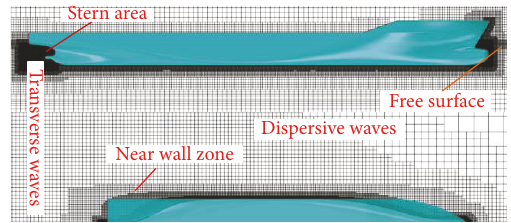
Figure 4: Computational meshes for flow field simulations of